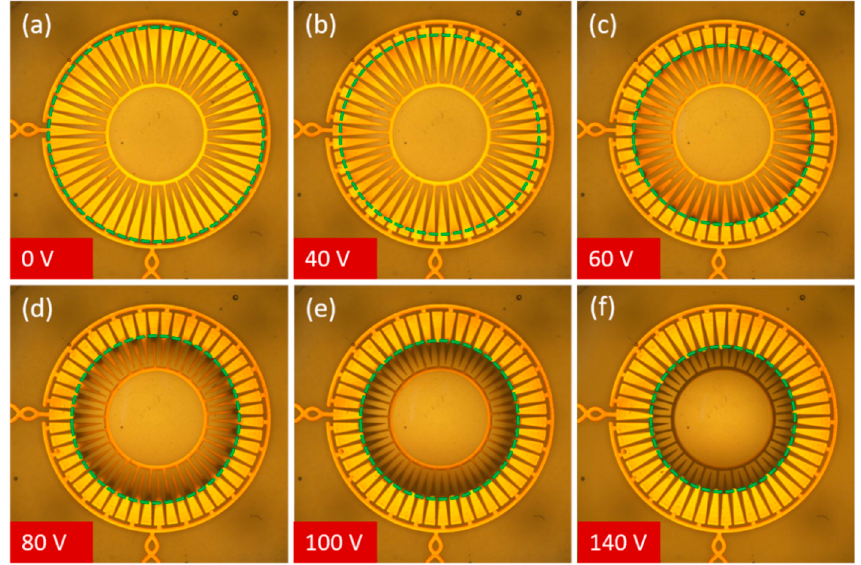
Figure 4. Images of a single lens during actuation, where all applied voltages are AC square waves at 10 kHz, all values peak-to-peak. The dashed green circles have been added to highlight the boundary between the oil droplet and the water that surrounds it. ( a ) The initial, rest state of the lens. With no applied voltage the oil droplet is pinned at the hydrophilic / hydrophobic boundary. ( b ) At 40 V, the oil droplet has begun to be squeezed as the water is attracted toward the underlying electrodes. This squeezing increases steadily with increased applied voltage as seen in ( c ) at 60 V, ( d ) at 80 V, ( e ) at 100 V and finally ( f ) at 140 V.